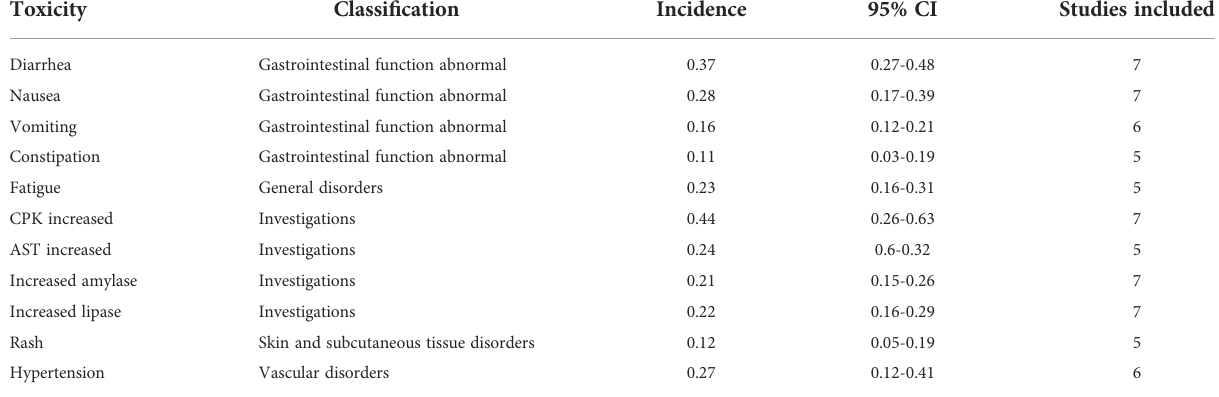
TABLE 2 Summary of